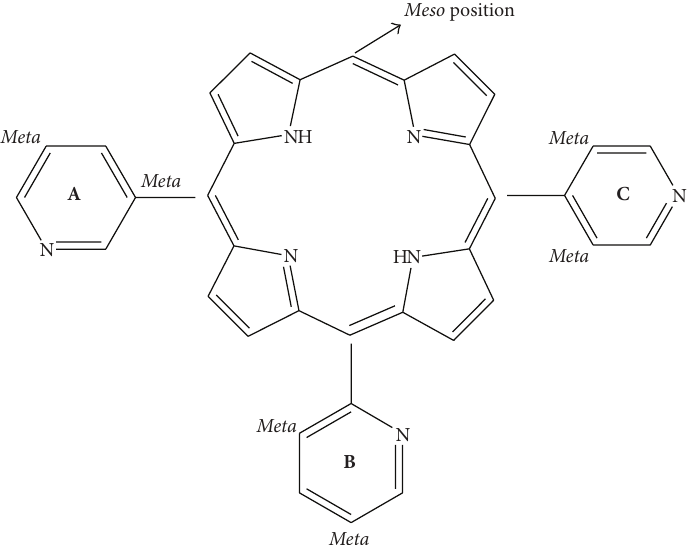
F 5: e meta positions of pyridyl substituents relative to the meso carbon atoms of H